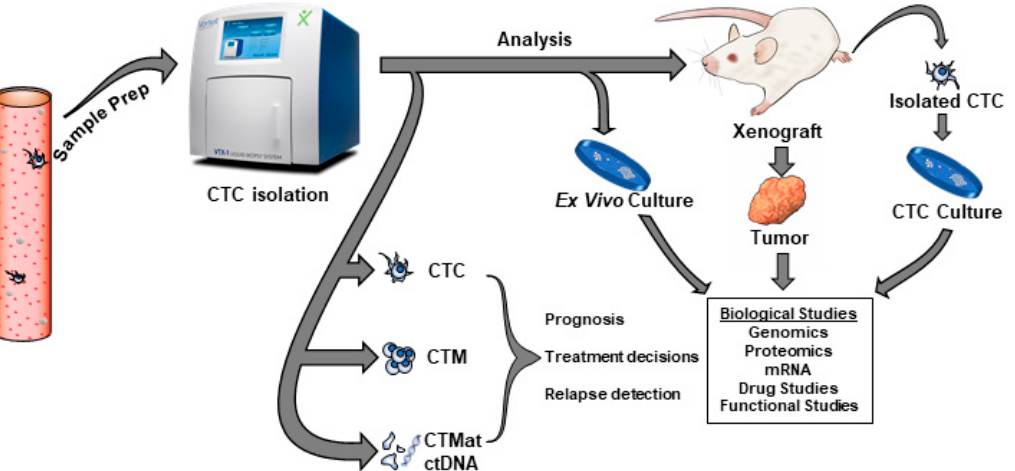
Figure 4. Workflow concept for the isolation of CTCs and subsequent analysis. Patient blood is passed through a capture device which enriches for tumor cells. Captured cells are then identified, enumerated and characterized. Cells can then be cultured and subjected to further biological and functional analysis.